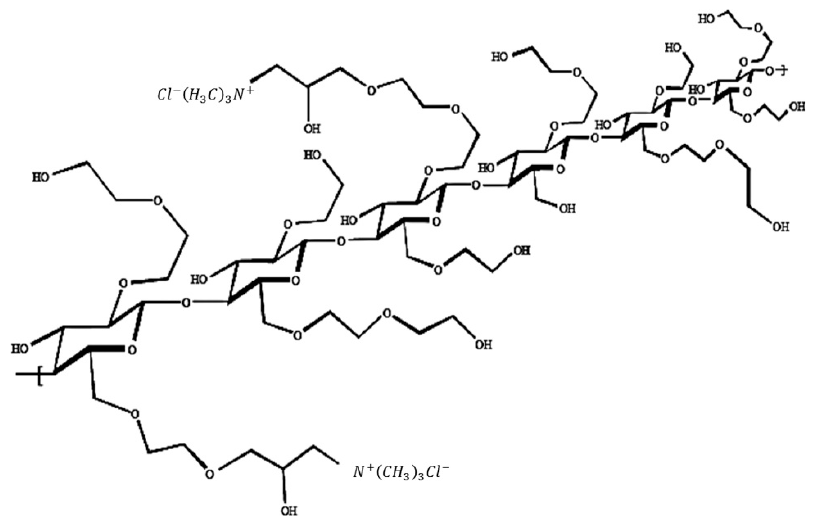
Figure 1. Generic structure of cationic hydroxyethyl cellulose (cat-HEC) polymers. Adapted with permission from Ref. [26]. 2004 Oxford University Press.